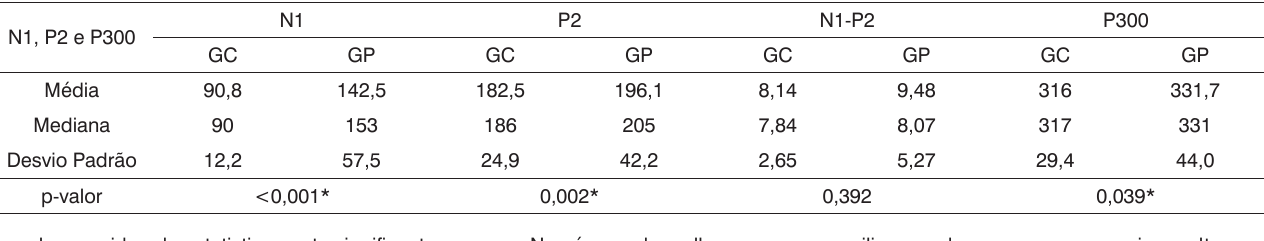
Tabela 2. Comparação dos valores médios das latências dos componentes N1, P2, P300 (em ms) e da amplitude N1-P2 (em µv) entre os grupos controle e pesquisa (N=60).